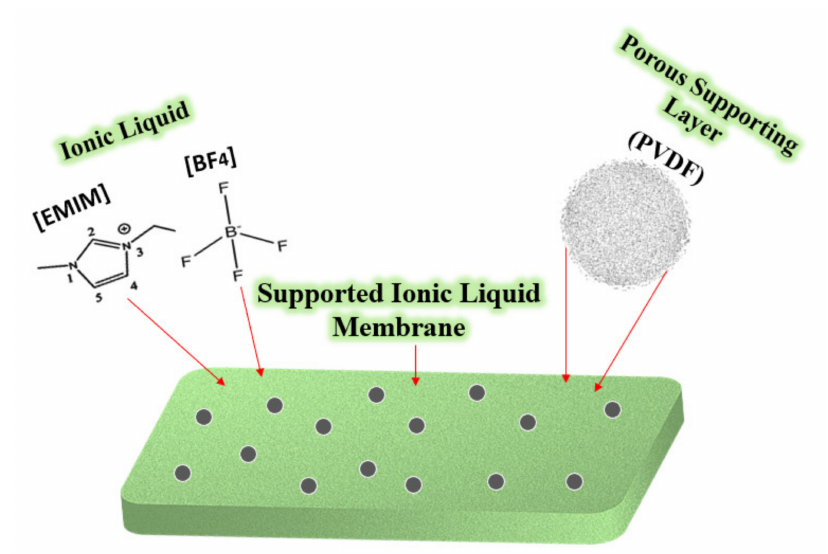
Figure 3. Theoretical scheme of a supported ionic liquid membrane